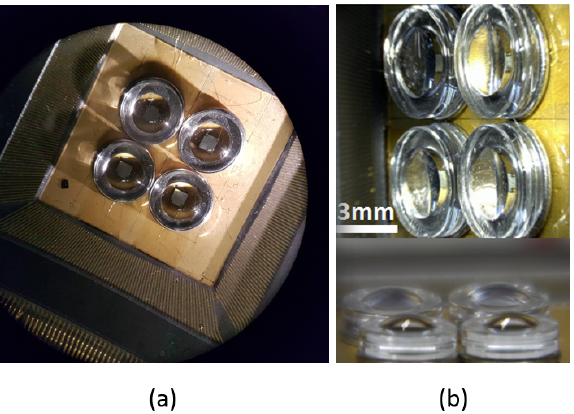
Figure 3. ( a ) LED matrix on ceramic quad flatpack. ( b ) Optical microscope image of LED matrix with aspheric